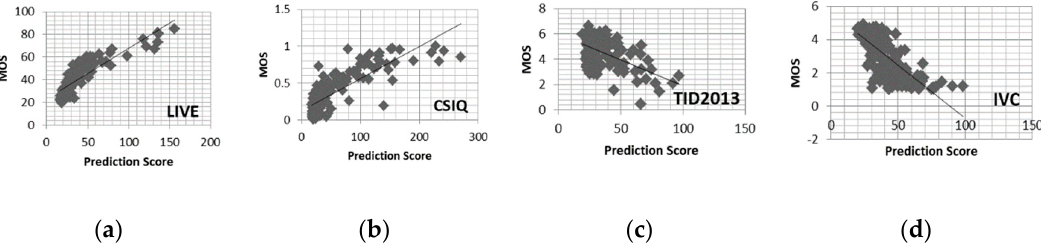
Figure 10. Scatter plots of objective scores predicted by BM-IQE versus subjective scores on ( a ) the LIVE image database; ( b ) the CSIQ image database; ( c ) the TID2013 image database; ( d ) the IVC image database.